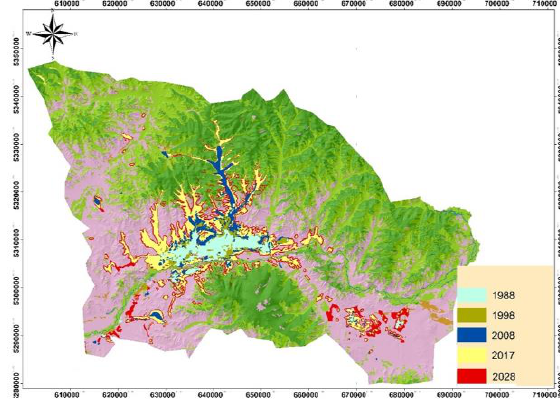
Figure 1. Land-use change (2008- 2017) and model prediction (2028) For the data validations, and accuracy assessment error matrix was calculated to compare with archived field reference data mapped in two years 1988 and 2009. In general, the classification map we create was sufficiently accurate and closely representative of the referenced field survey data of archived material. The overall accuracy compared with references is 0.93, meaning that 93% of the cells are identically classified in both maps. We found that the land use/land cover map resembles previous field survey data assessments of areas with the same classes of land use. Our Markov chain model map corresponded with the field reference map. The Kappa coefficient of land use and land cover map in 2017 had a positive 0.82 value, which indicates that the classified map has a strong agreement with ground truth data. This result showed that the CA-Markov chain model has good potential to accurately predict future land-use changes. To define the ROC, Figure 2 plots the rate of true positives on the vertical axis versus the rate of false-positives on the horizontal axis for the simulated urban area image of 2028 with an initial urban area. The initial urban area had a rate of ROC with a simulated urban area in 2028, which was 0.52, respectively (Table 4).